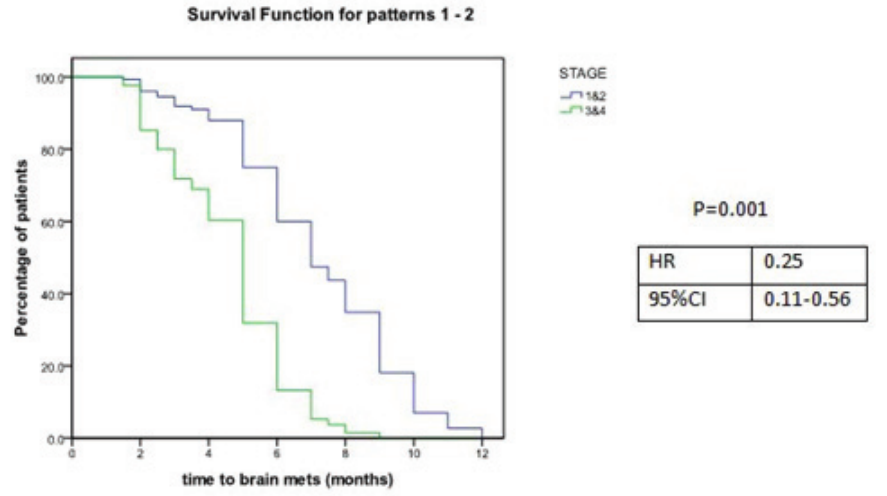
Figure 1: Cox regression analysis of time to development of brain metastases for patients with NSCLC according to stage group at presentation and its statistical